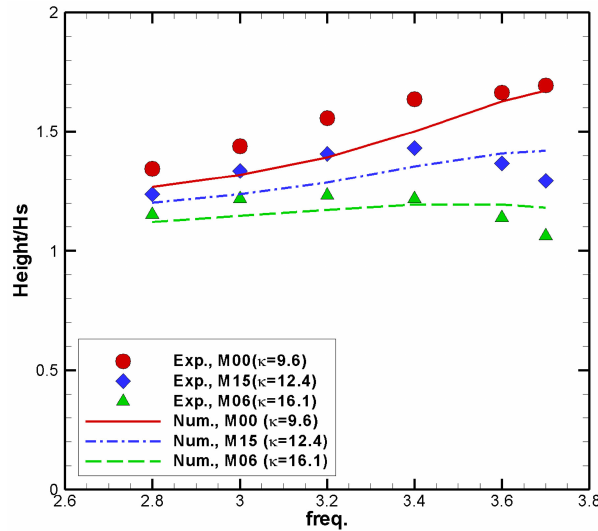
Figure 15. Heave RAO of the HPA with different irregular wave conditions.